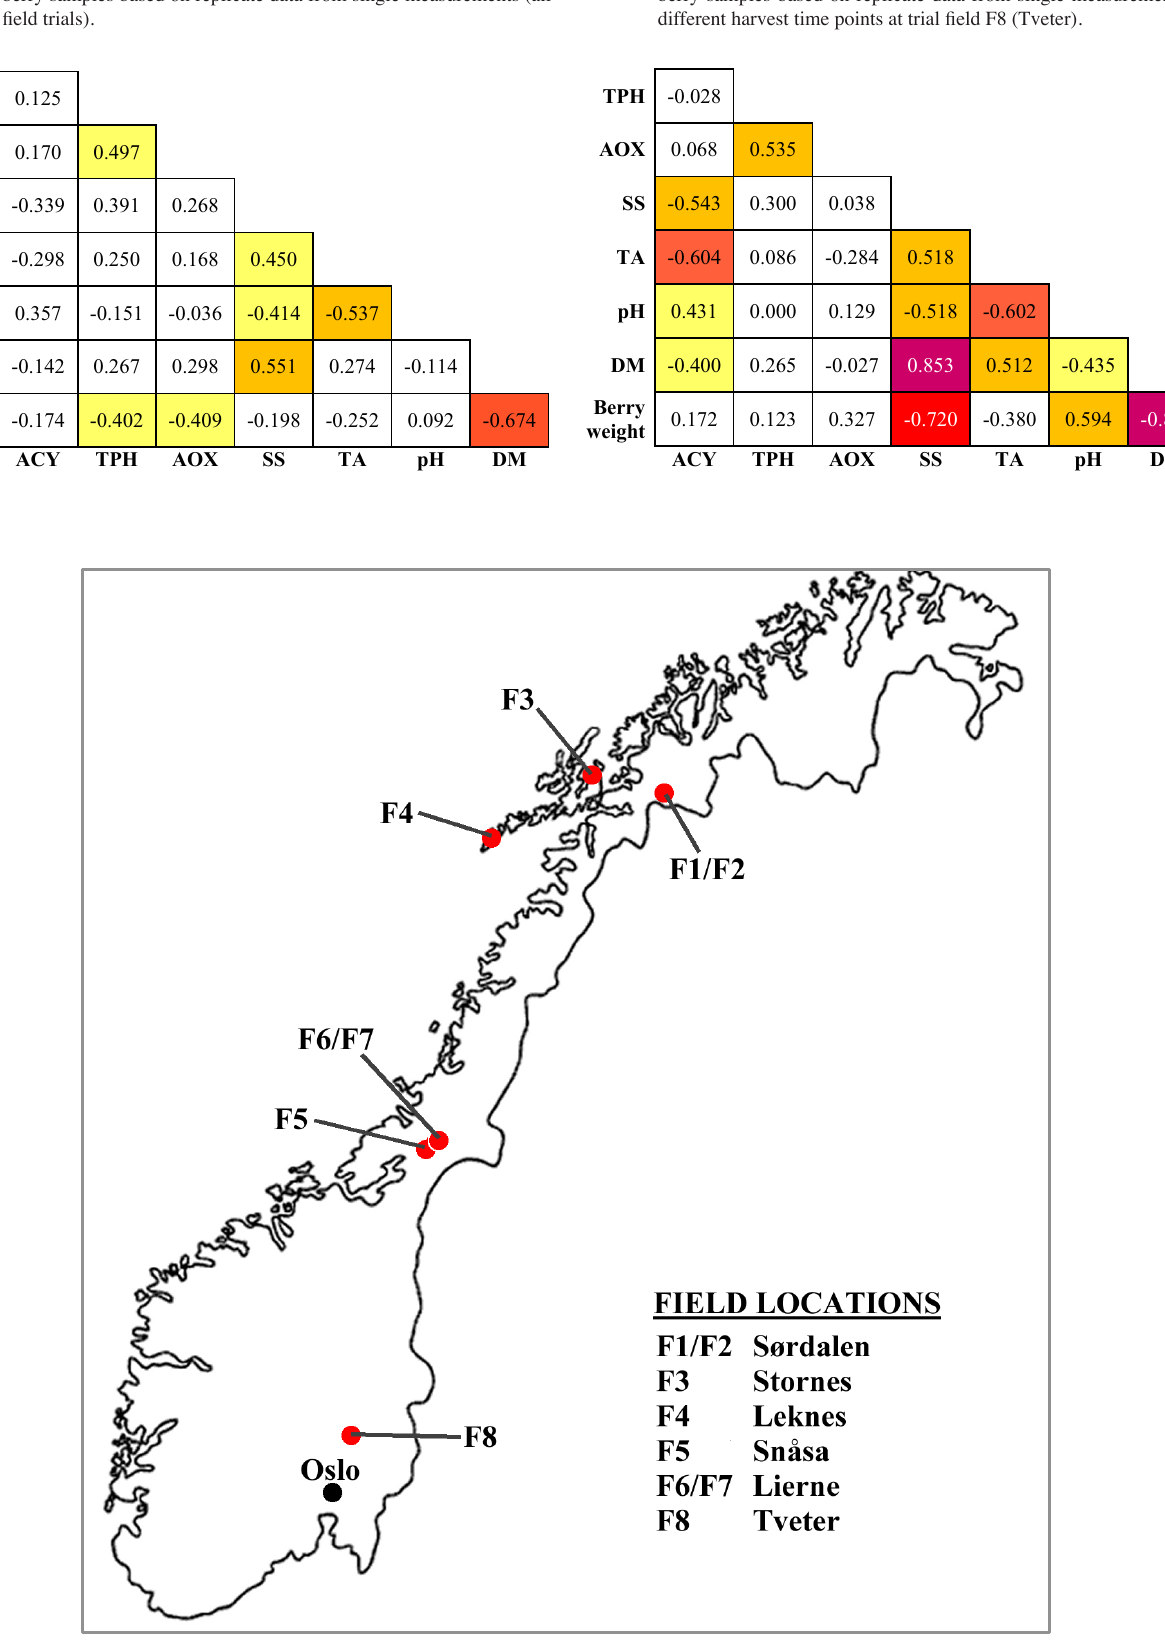
Supplementary Fig. S1: Trial field locations in Norway.